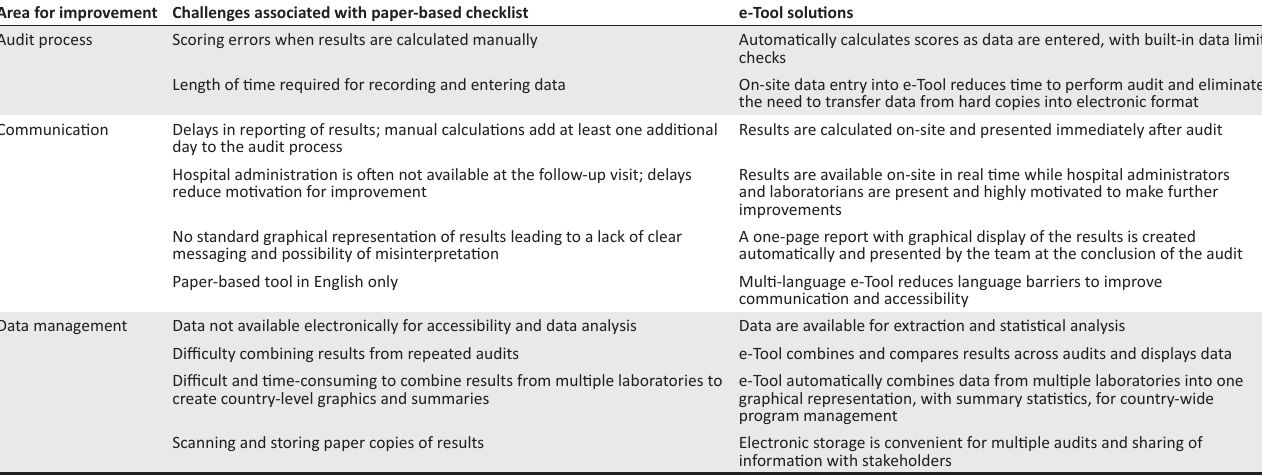
TABLE 1: Challenges of the paper-based SLIPTA checklist, and solutions provided by the SLIPTA e-Tool. Area for improvement Challenges associated with paper-based